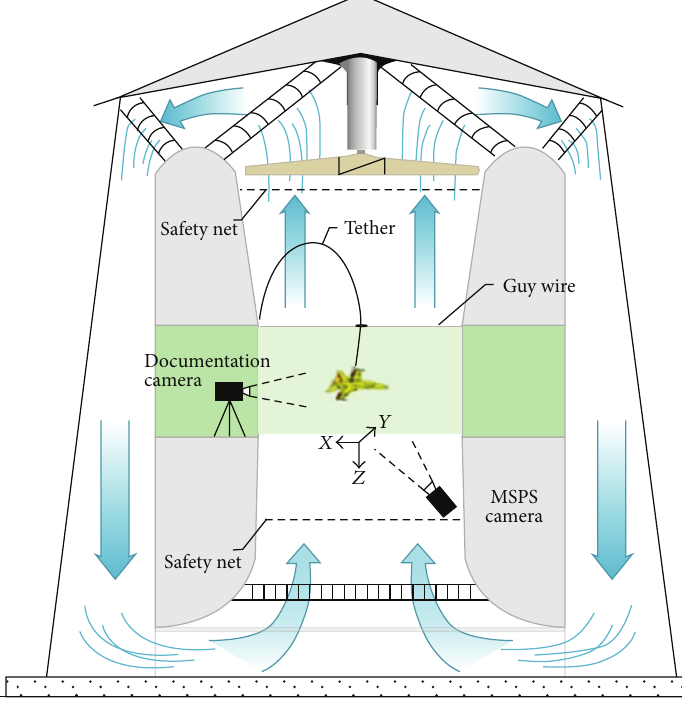
Figure 5: Sketch of the NASA Langley 16-ft TT FTR apparatus [24].